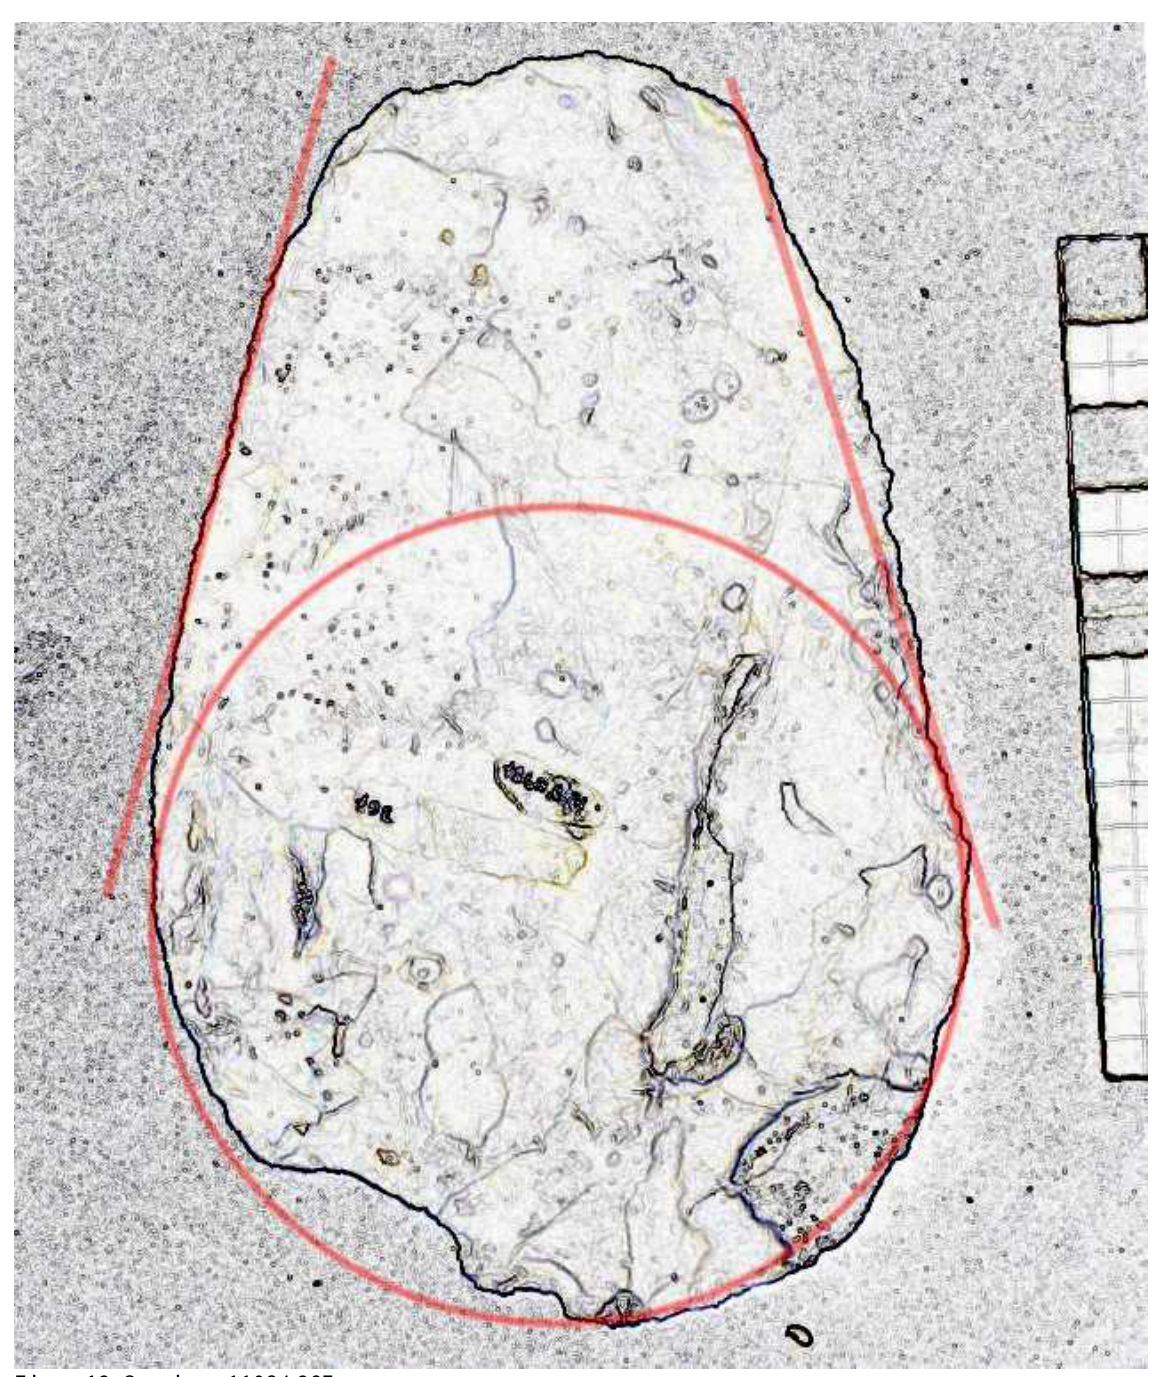
Figure 13. Specimen 11984